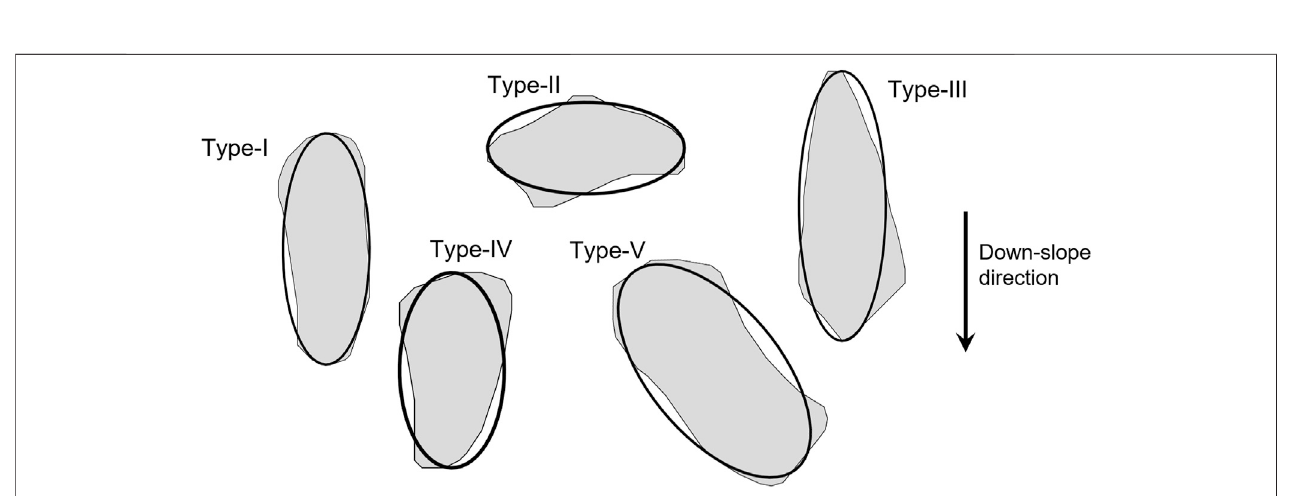
FIGURE 3 | The commonly observed shapes of the landslide source